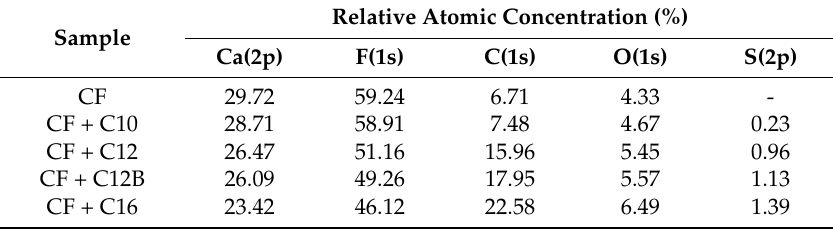
Table 1. Relative atomic concentration of the fluorite surface elements in the absence and presence of the collectors.